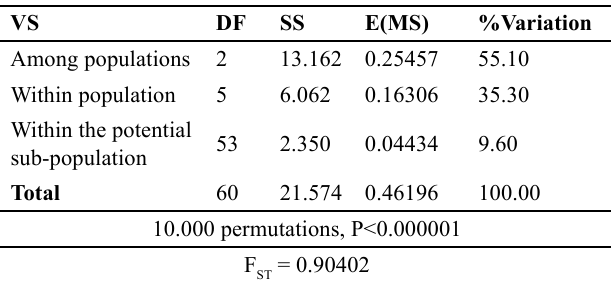
Table 2 . Analysis of Molecular Variance (AMOVA) applied to three hierarchical levels on data set after reallocation. VS : Variation Source; DF : degrees of freedom; SS : sum of squares; E(MS) : Estimate medium squares - variance